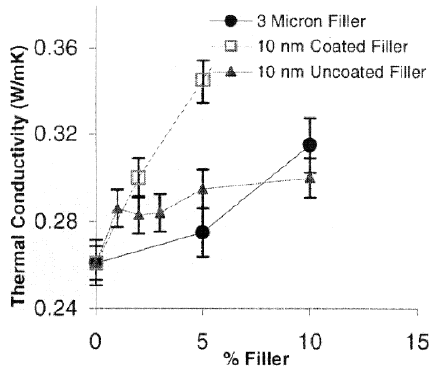
Figure 40. Thermal conductivity in function of the filler concentration characteristics for pure PI, PI microcomposites and PI nanocomposites (nanoparticles uncoated and coated) (© 2016 IEEE. Reprinted, with permission, from [174]).